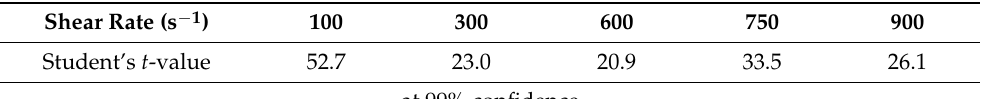
Table 3. Calculated Student’s t-values for comparison of mean platelet surface percentage coverage on bare and MEG-OH-modified steel